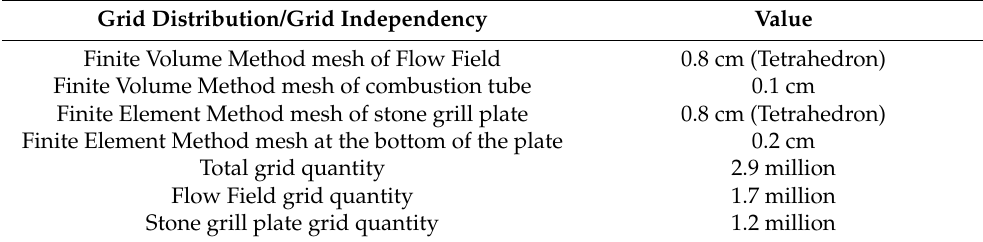
Table 2. Grid distribution and grid independency of stone grill plate in barbecue